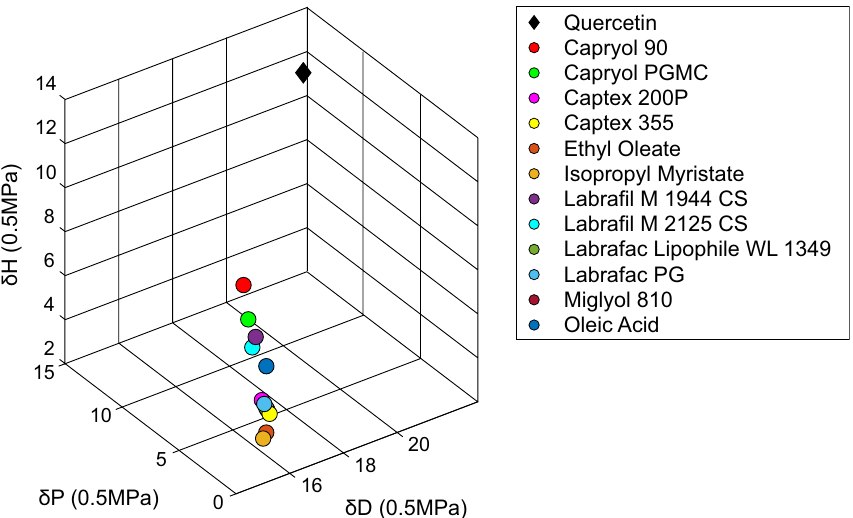
Figure 1. 3D diagram representing the Euclidean distance between QRC and the different liquid lipids.